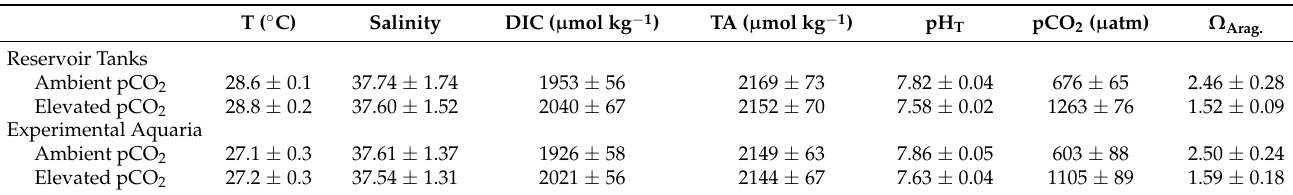
Table 1. Environmental conditions and carbonate chemistry (mean ± 1 sd) of experimental system seawater from mea- surements taken during morning. Temperature and Salinity were measured daily in both reservoir tanks ( n = 2) and all experimental aquaria ( n = 56). Dissolved inorganic carbon (DIC) and total alkalinity (TA) were measured every seven days in both reservoir tanks ( n = 2) and half of the experimental aquaria ( n = 14 per pCO 2 treatment). The remaining variables were calculated from T, S, DIC, and